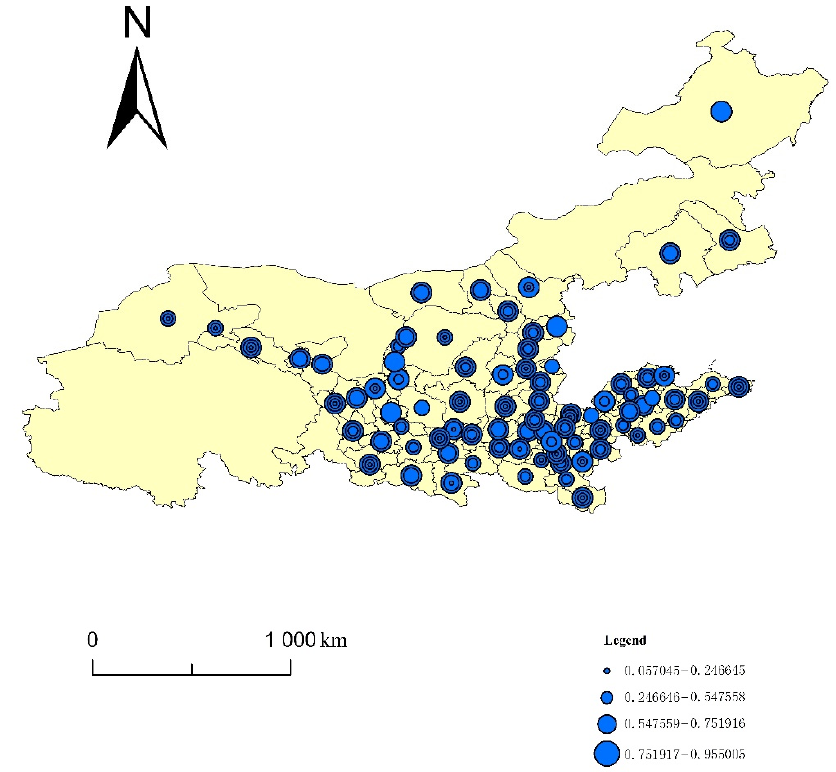
Figure 2. Spatiotemporal evolution of the urban ecological pressure in the YRB.